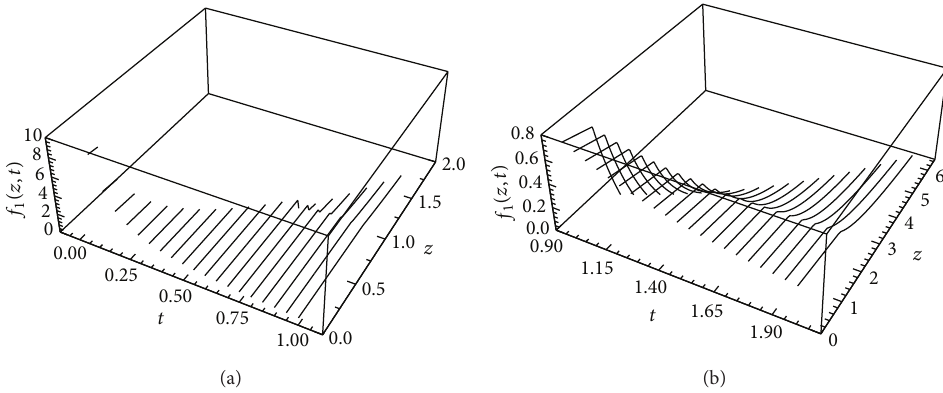
(𝑧, 𝑡) , we have split its representation 1